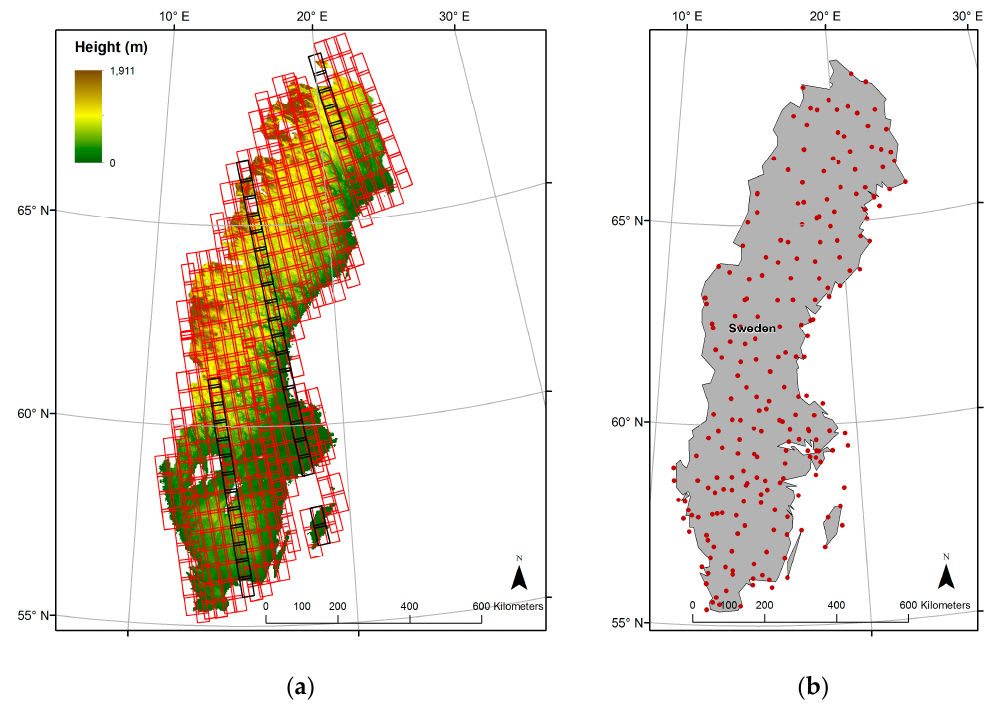
Figure 4. ( a ) Illustration of the TanDEM-X coverage of Sweden with the three stripes of low height-of-ambiguity highlighted in black. The scenes are overlaying an ALS DTM to illustrate the structure of the landscape. ( b ) The available weather stations from which temperature data were collected. National map © 1995–2017 Esri.